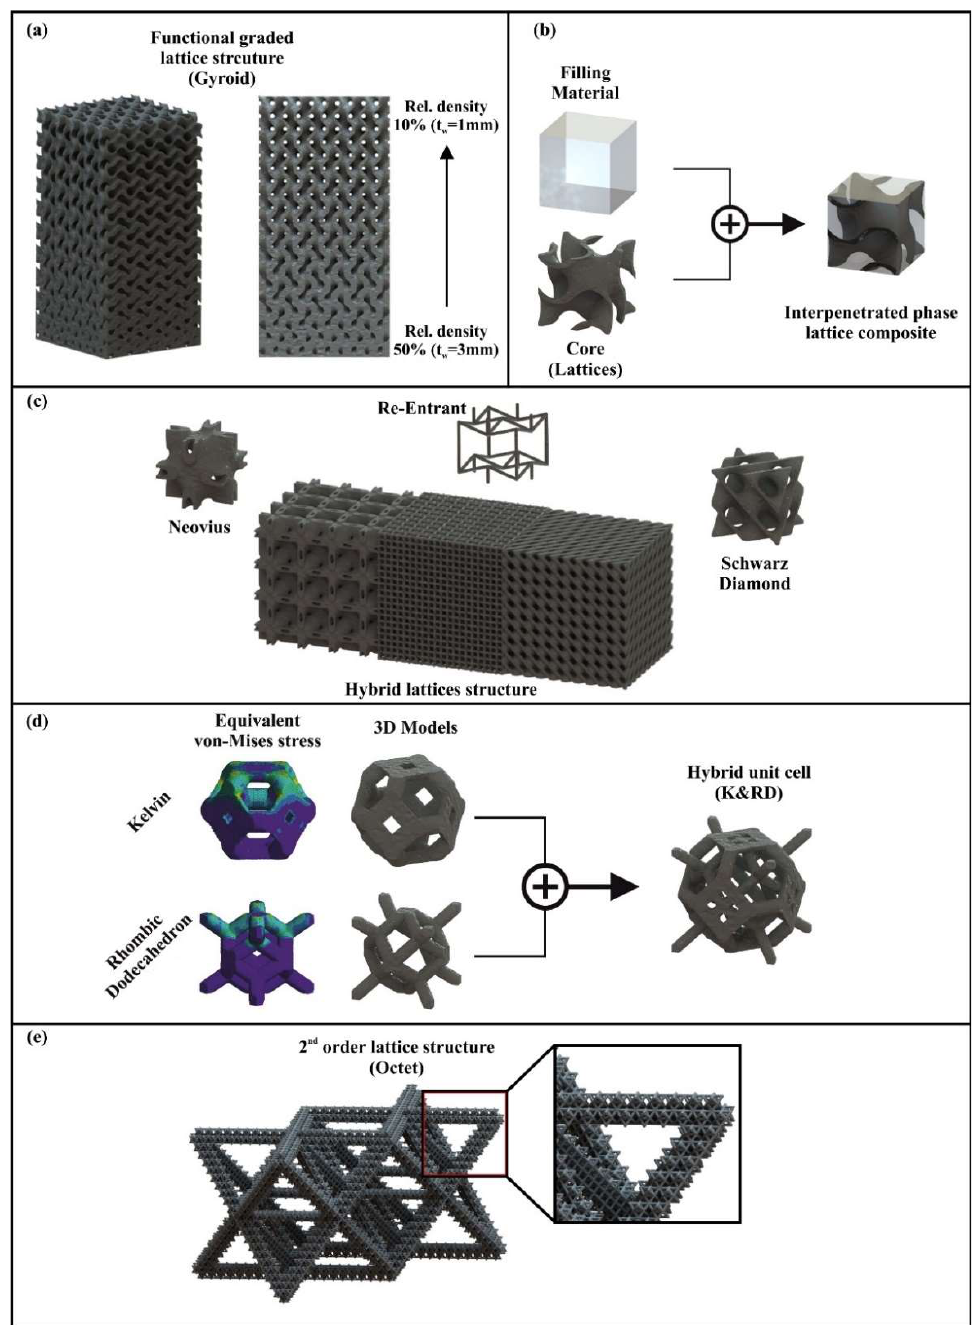
Figure 3. Optimization processes of architected materials: ( a ) Functional gradation; ( b ) Interpenetrating phase composites with architected material; ( c ) Hybridization of a structure; ( d ) Hybridization of a unit cell; ( e ) Lattice structure with higher-order.